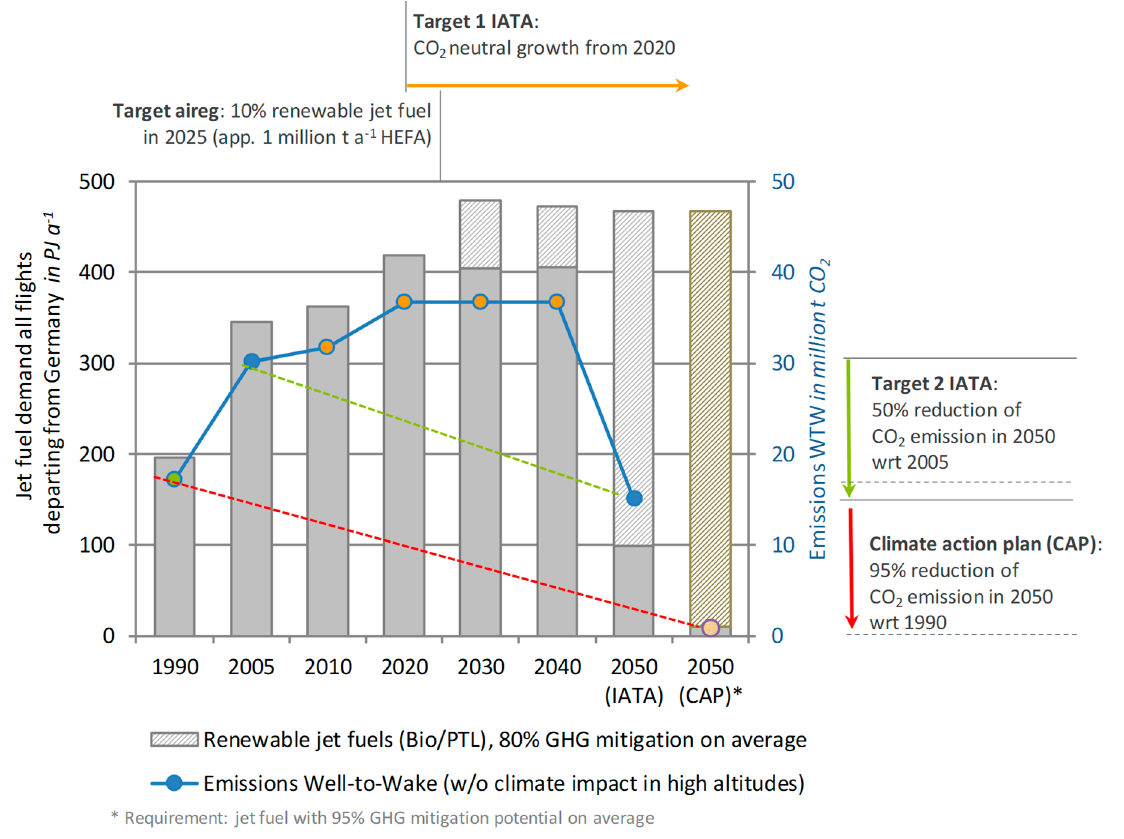
Figure 1. Jet fuel demand of all flights departing in Germany, emissions to be reduced, and the share of required renewable jet fuels to fulfill targets like of aireg, IATA, and climate protection plan (adapted from [3]).